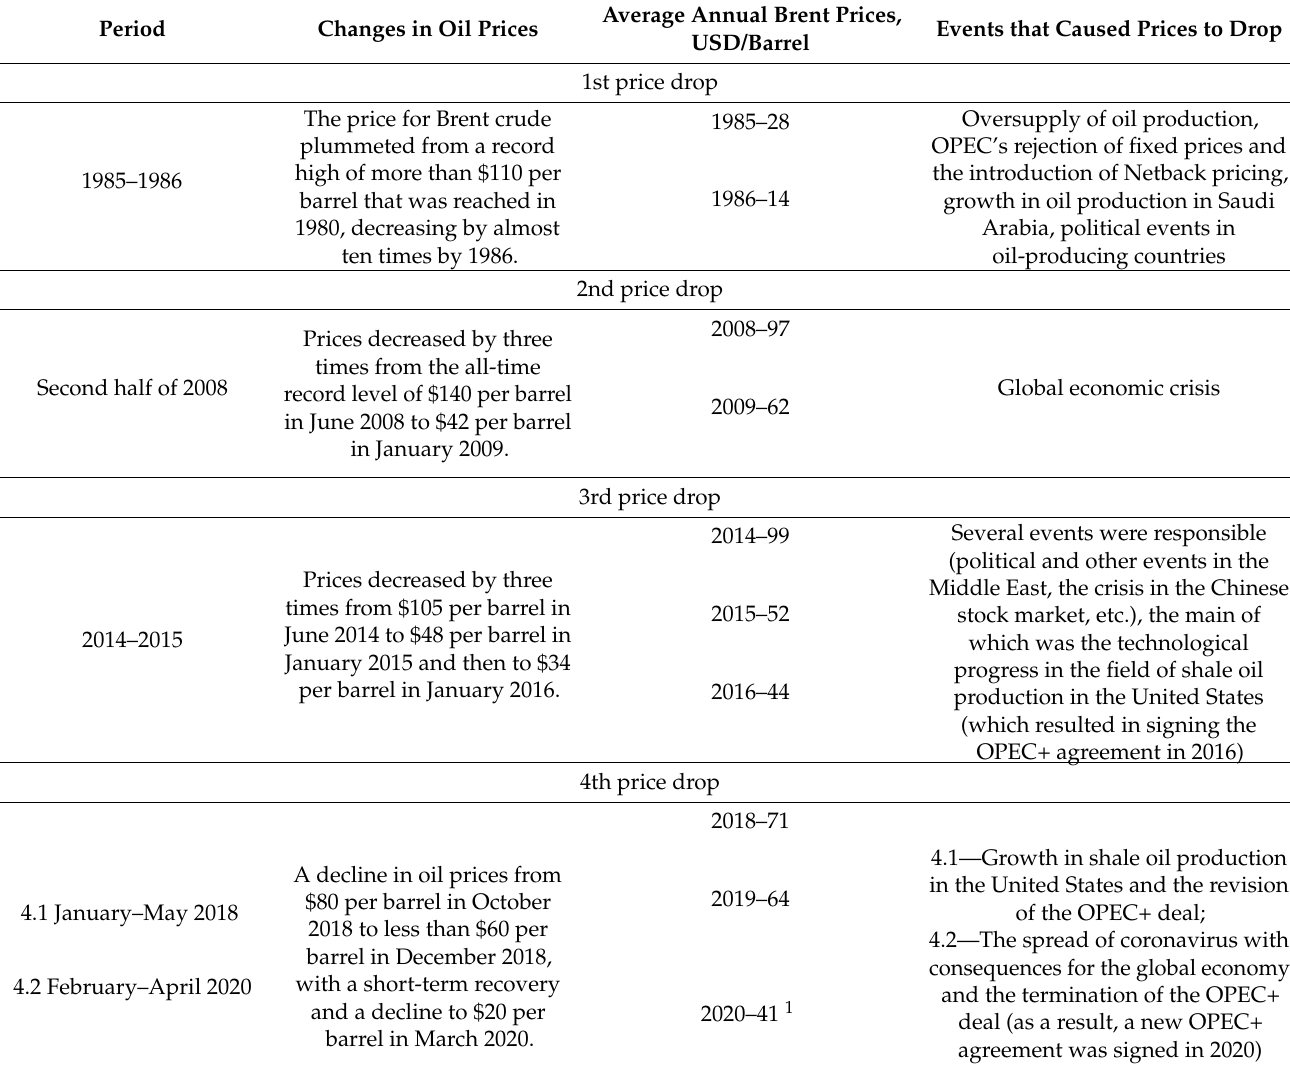
Table 1. Event analysis comprising changes in oil